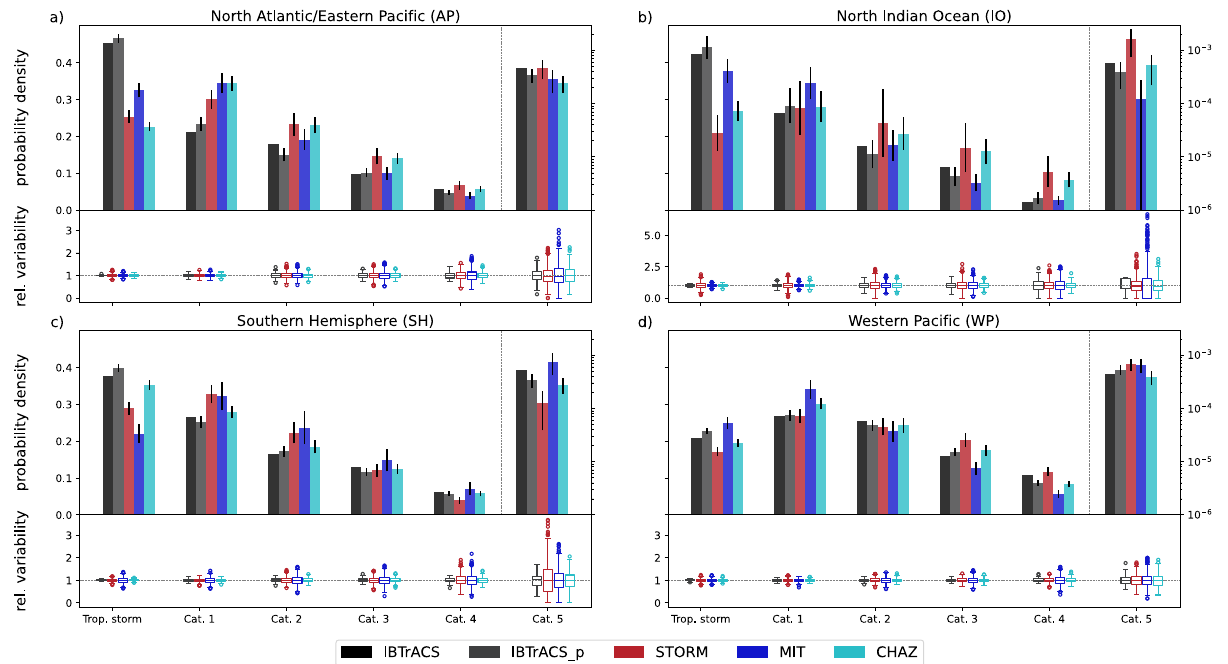
Fig. 1 | Regional distribution of tropical cyclone intensities for the fi ve track sets. a – d Compare the relative frequency of tropical cyclones (TCs) belonging to eachcategoryof the Saf fi r-SimpsonHurricane Wind Scaleacrossthe fi ve tracksets (IBTrACS, IBTrACS_p, STORM, MIT,CHAZ), separately for the four regions a North Atlantic/Eastern Paci fi c, b North Indian Ocean, c Southern Hemisphere, and d Western Paci fi c. The mean and standard deviation (black error bars) over all the subsamples in each category (see Methods) of the frequencies are shown in the